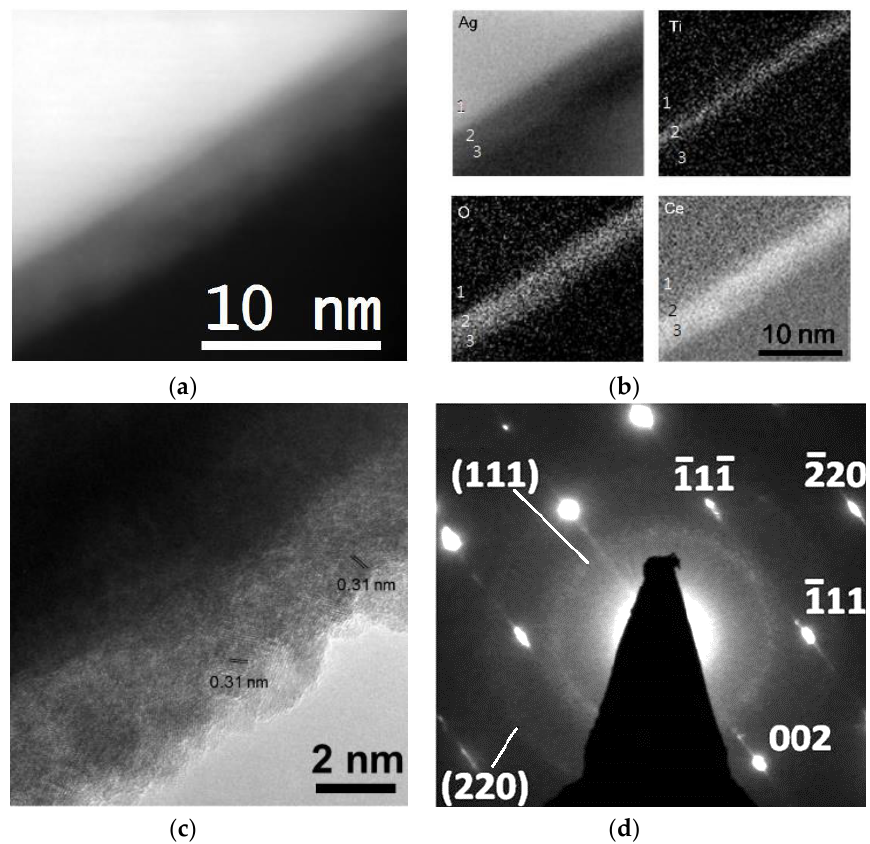
Figure 5. Ag/TiO 2− x /CeO 2 nanowire oxide shell microstructure analytical results: ( a ) HAADF image, ( b ) EELS elemental mapping taken from the marked region in ( a ) (point 1, point 2 and point 3 indicate Ag wire, TiO 2− x and CeO 2 , respectively), ( c ) HRTEM images, and ( d ) selected area diffraction patterns.